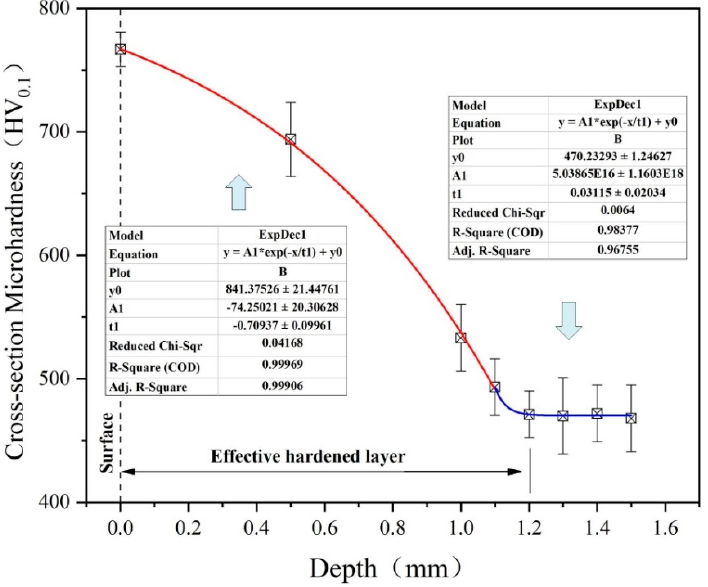
Figure 5. The cross-section microhardness of carburized specimen along the depth.